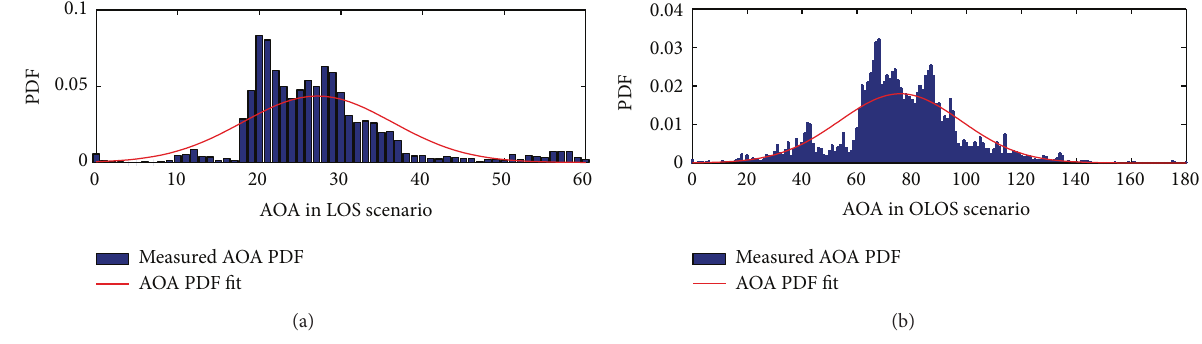
̂𝜃 in LOS and OLOS segment. scat